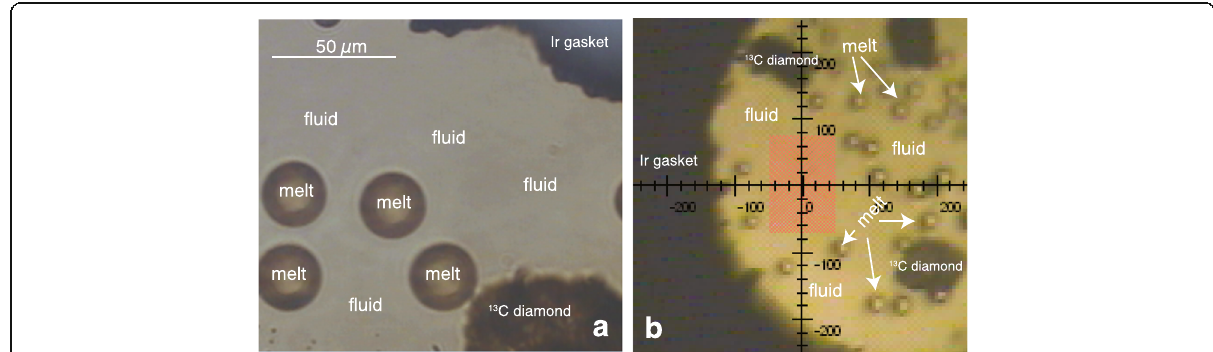
Fig. 1 Microphotograph of samples in the diamond cell at 550 °C and 262 MPa. a As viewed through the optical microscope during micro-Raman measurements. The width of the field of view is 200 μ m. b View of the sample through the optical microscope in the microFTIR system. The numbering on the crosshair indicates μ m. The shaded area centered in the cross-hear indicates the position and dimension of the aperture (100 × 150 μ m) for fluid examination in this particular experiment